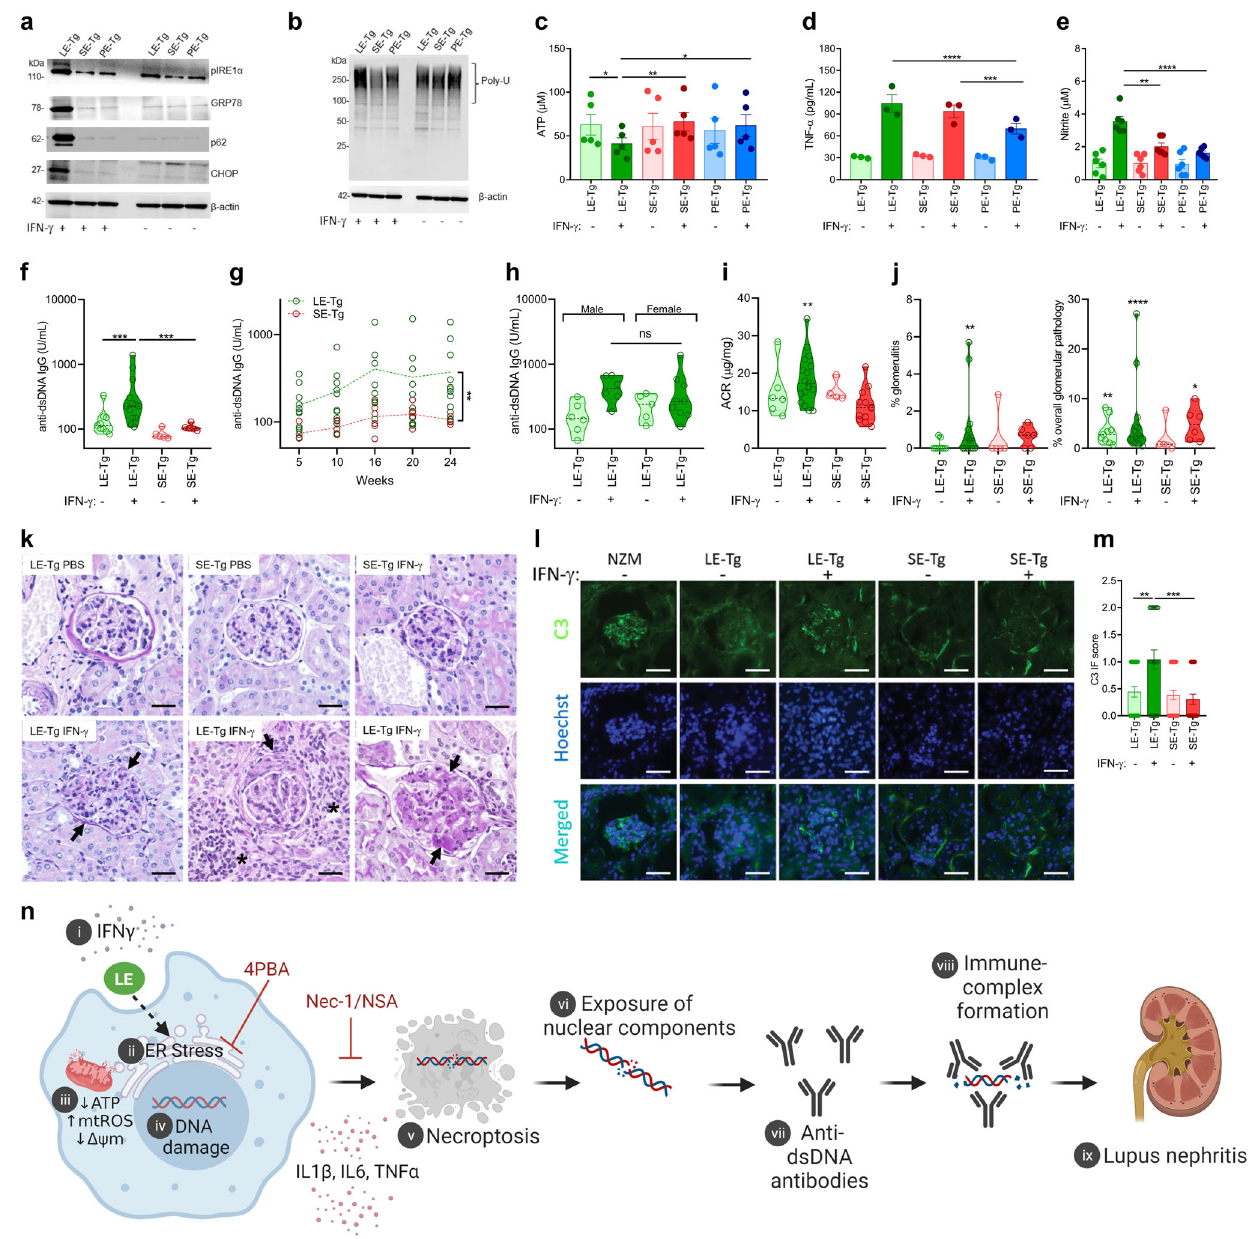
Fig. 7 Ex vivo and in vivo effects of physiologically folded LE-expressing HLA-DR molecules. a , b Immunoblots of ER stress (pIRE1- α , CHOP, GRP78) and proteasomal degradation (p62) markers a , and poly-ubiquitinated proteins b , in BMDMs derived from transgenic mice expressing physiologically folded HLA-DR β molecules coded by DRB1*03:01 (LE-Tg) , DRB1*04:01 (SE-Tg) , or DRB1*04:02 (PE-Tg) and cultured ex vivo in the presence or absence of IFN- γ